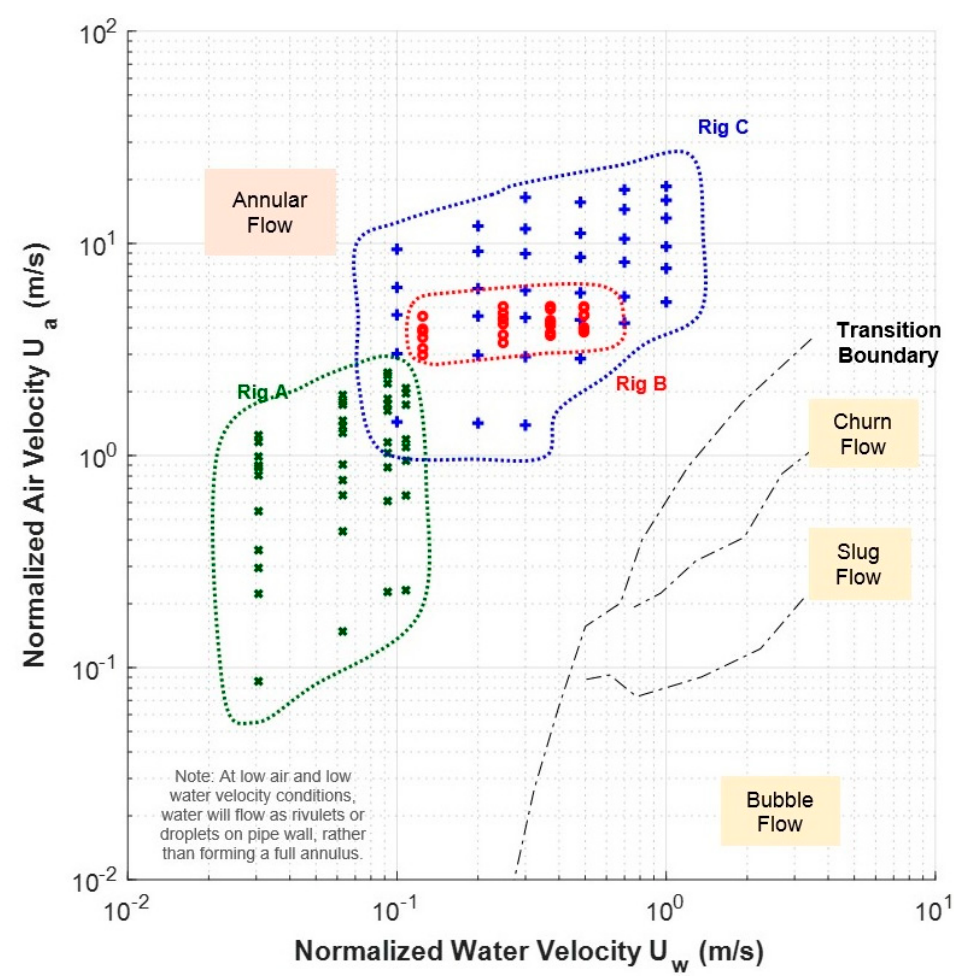
Figure 2. Flow pattern map for vertical downward air-water flow [18]. Rig ‘A’, Rig ‘B’ and ‘C’ experimental dataset test conditions shown for reference.